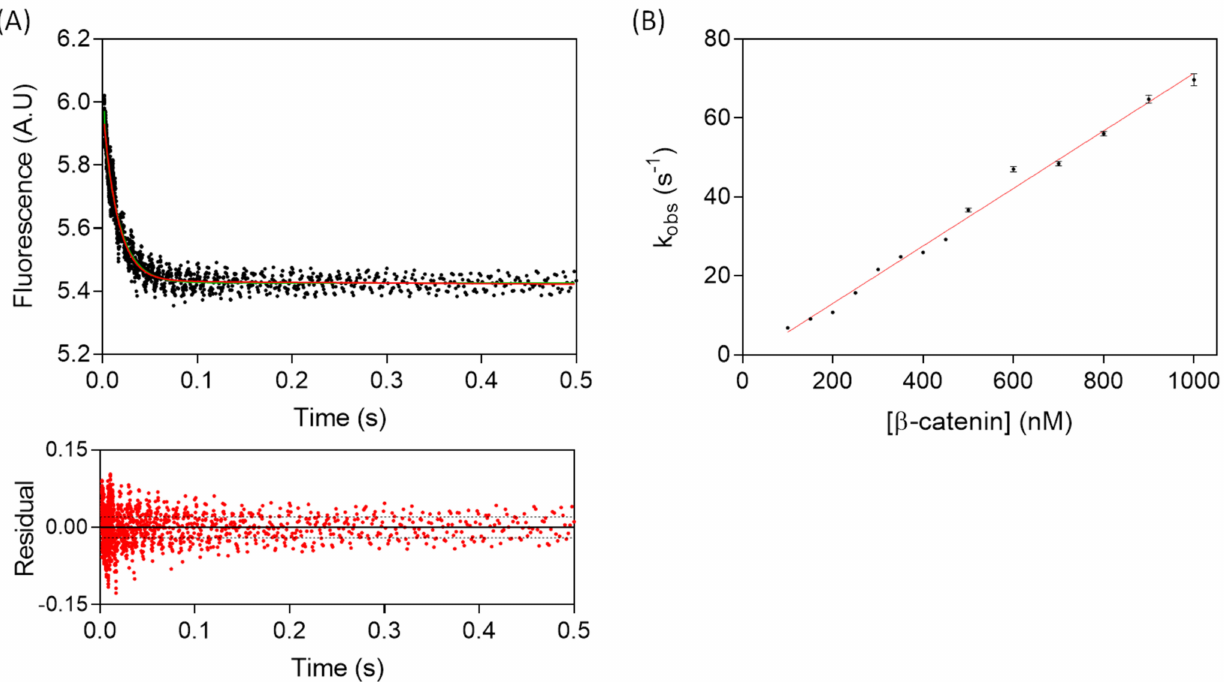
Figure 3. Stopped-flow fluorescence measurement of the association kinetics of TCF7L2 and β -catenin. ( A ) Time-dependent change in fluorescence upon the mixing of 10 nM fluorescent-labelled WT TCF7L2 (1–54) and 900 nM β -catenin. The data were fitted to a single-exponential function, and the residuals are shown below the main plot. ( B ) The observed rate constant was plotted as a function of the concentration of β -catenin, from which the association rate constant, k on , was calculated. The errors bars in ( B ) are the standard deviations of the fits. Experiments were performed in PBS buffer, 1 mM DTT at 15 ◦